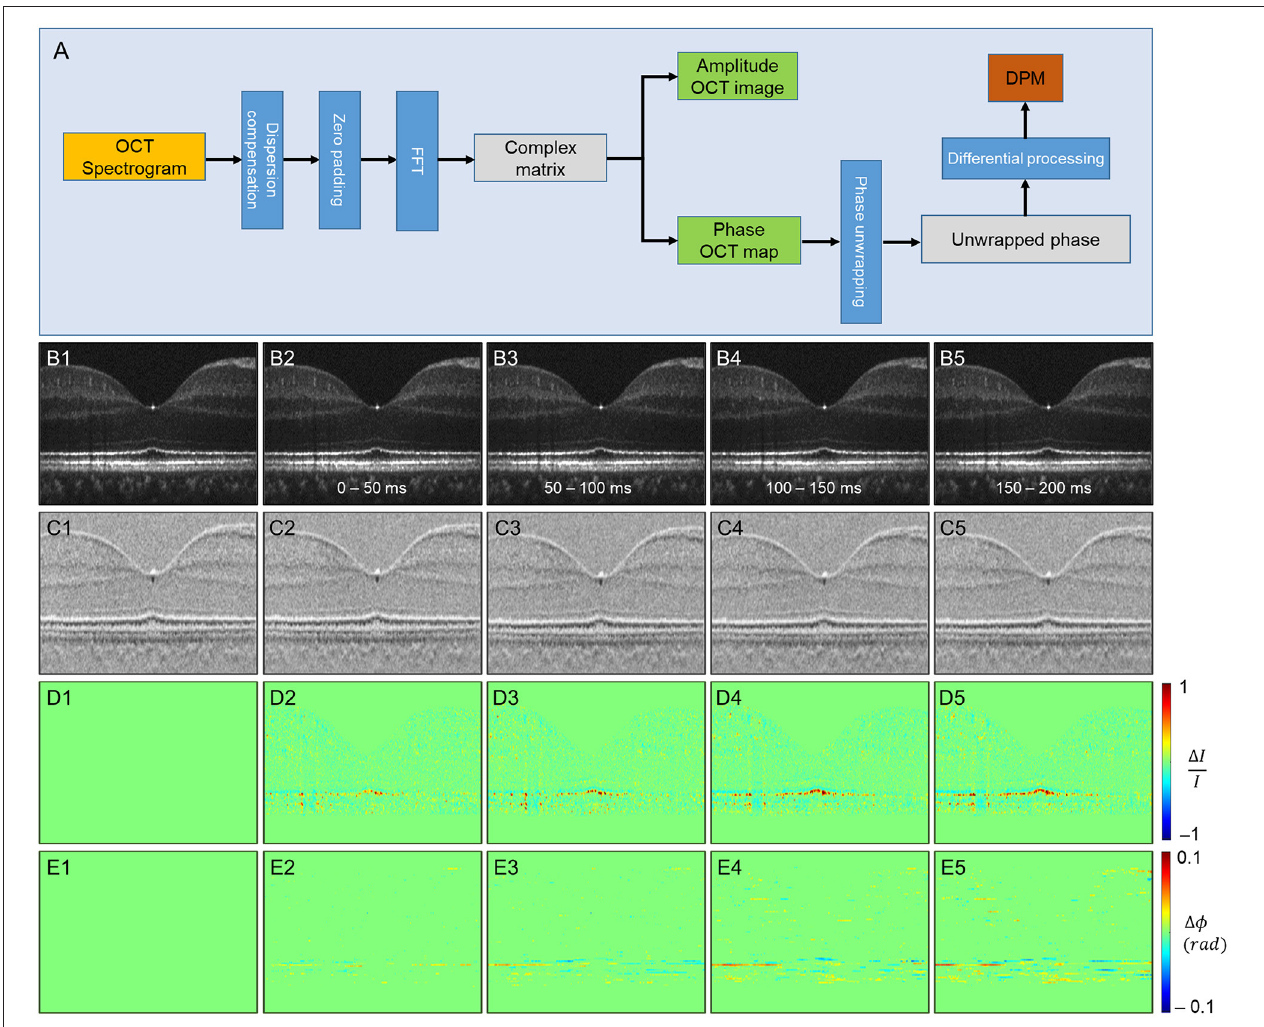
FIGURE 5 | Phase-resolved OCT imaging for differential-phase mapping (DPM) analysis. (A) A flow chart of amplitude OCT and DPM processing. (B–E) The amplitude-IOS and phase-IOS distribution. (B) Amplitude image sequence. (C) DPM sequence. (D) Amplitude-IOS sequence. (E) Phase-IOS sequence. Reprinted with permission from Ma et al. (